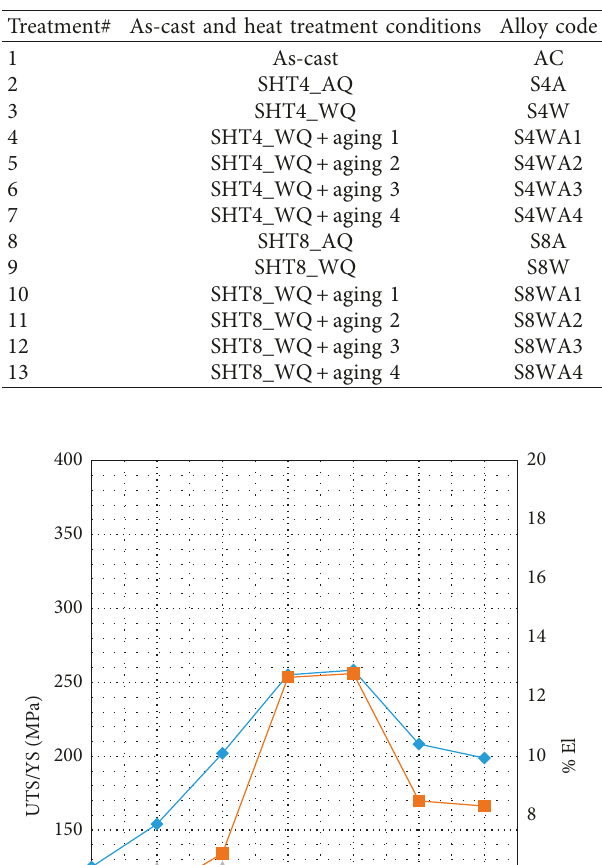
Table 3: As-cast and heat-treatment conditions and codes— shortened descriptions.